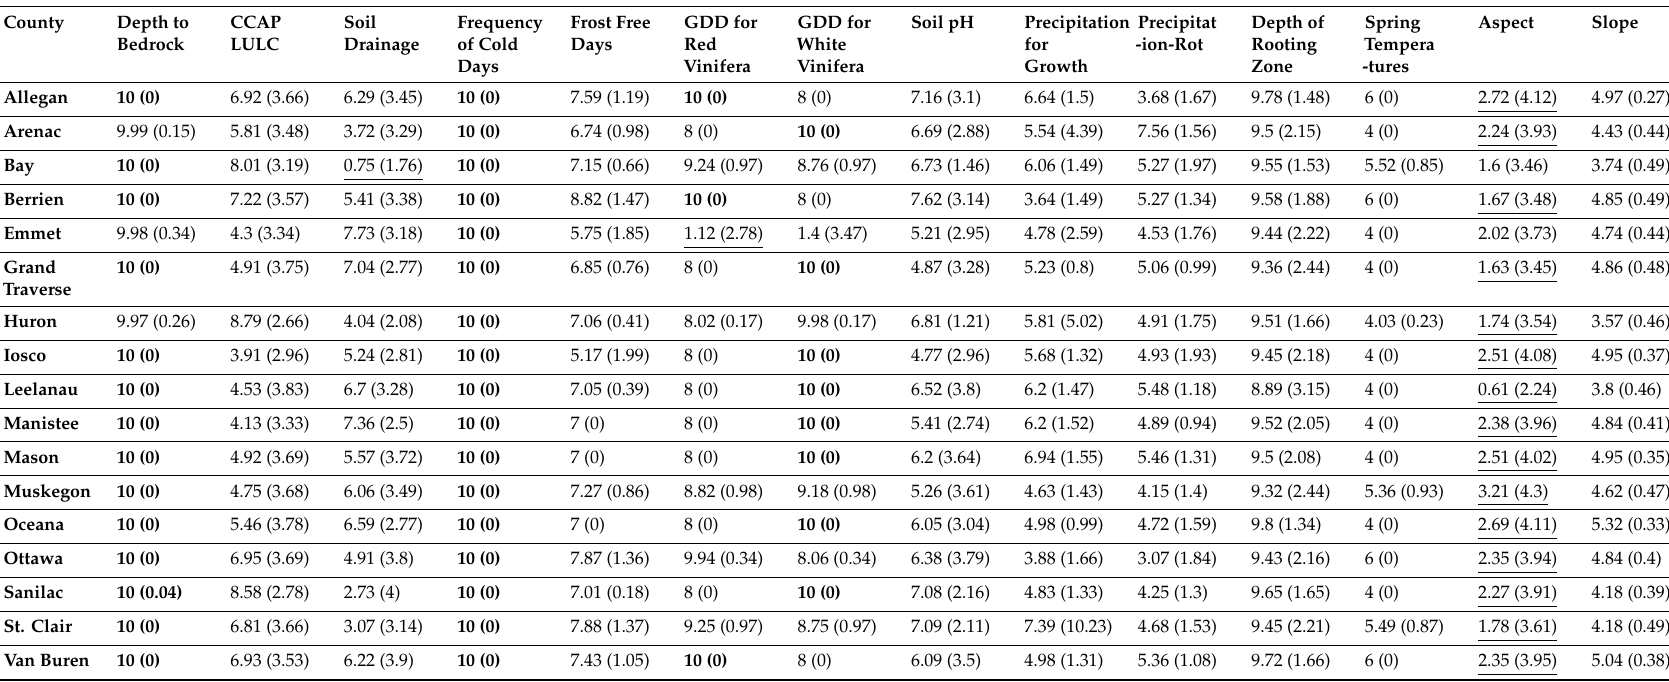
Table 4. Means and standard deviations (in brackets) of reclassified variables used in the final LSE models. Maximum class values per county are highlighted in bold while minimum values have been